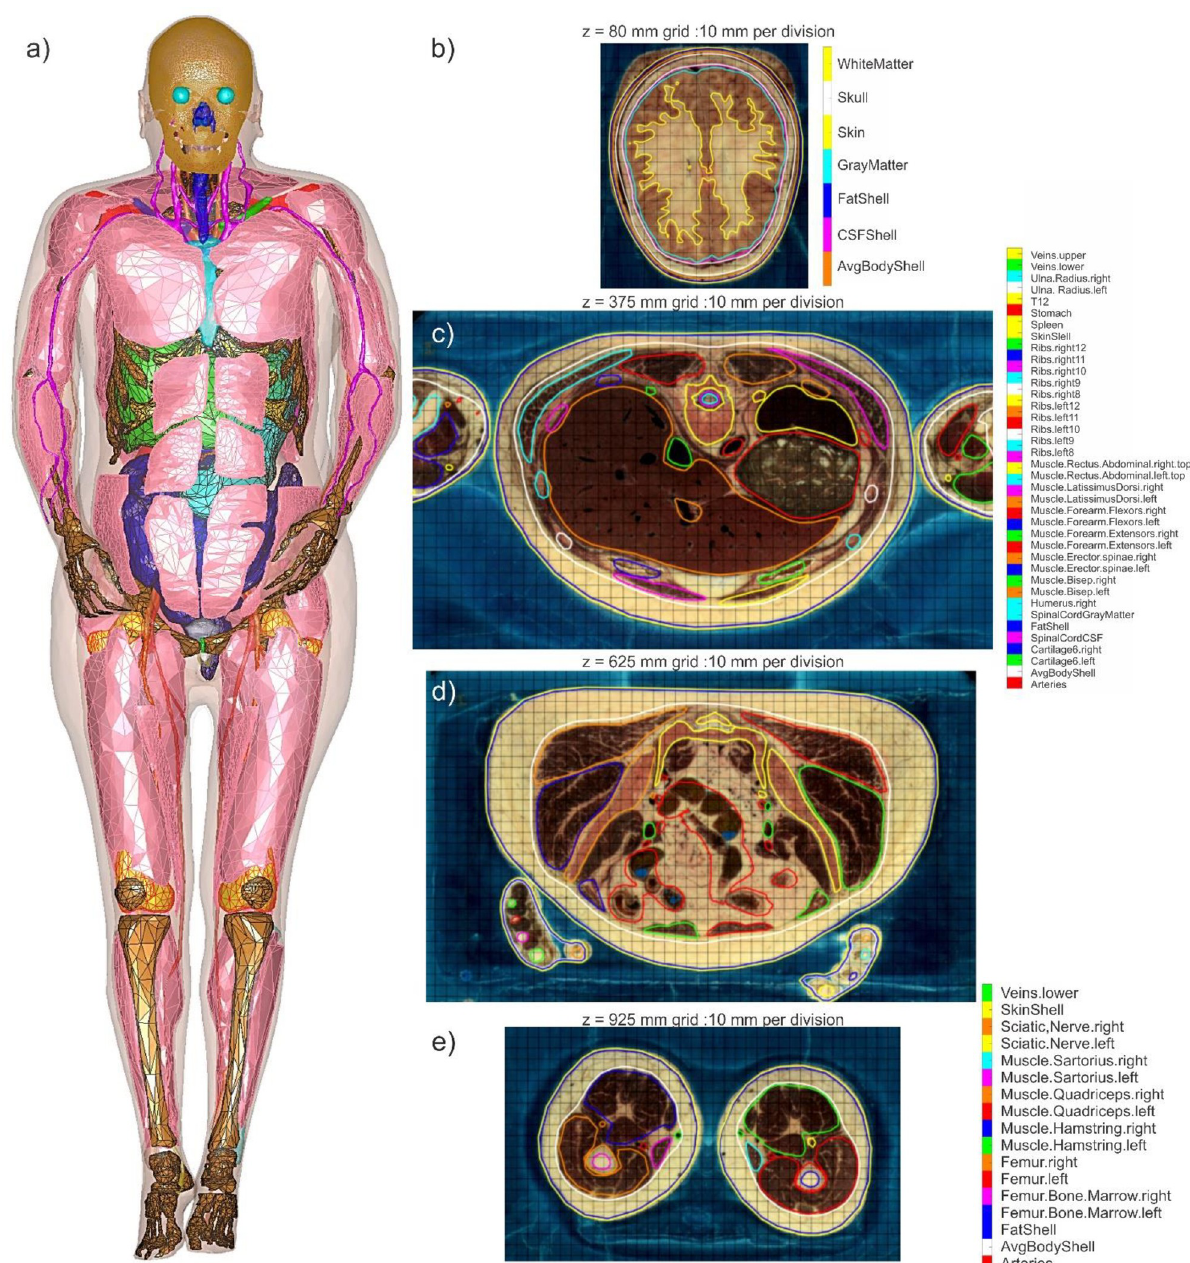
Fig 1. a)–Full-body Visible Human Project Female v5.0 CAD based computational phantom. The phantom is composed of 249 individual structures. Some individual muscles are removed for clarity. b-e) Examples of coregistration maps for surface meshes in different transverse planes with